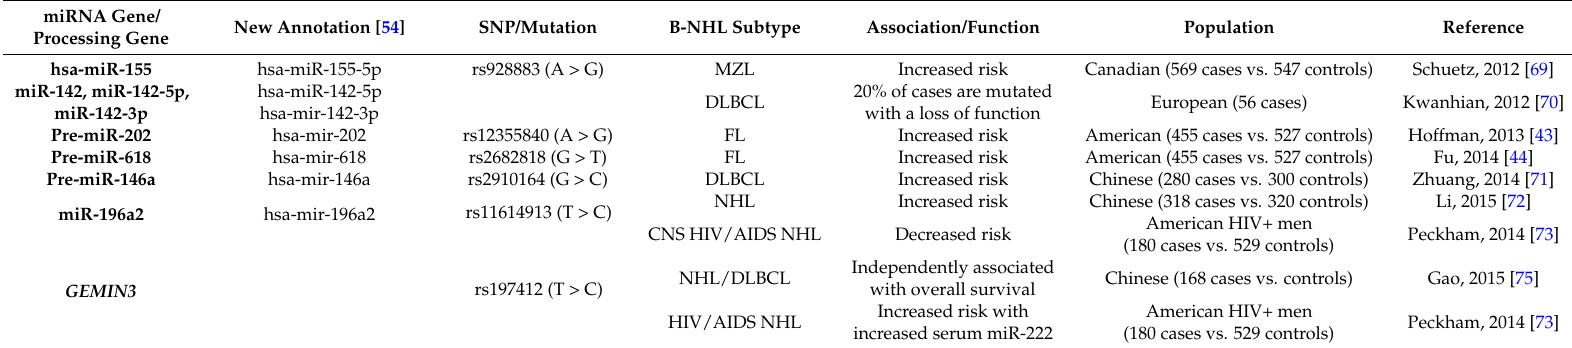
Table 2. A summary of single nucleotide polymorphisms in miRNA genes or their processing genes and their association and function in different non-Hodgkin lymphoma (NHL) populations and subtypes.